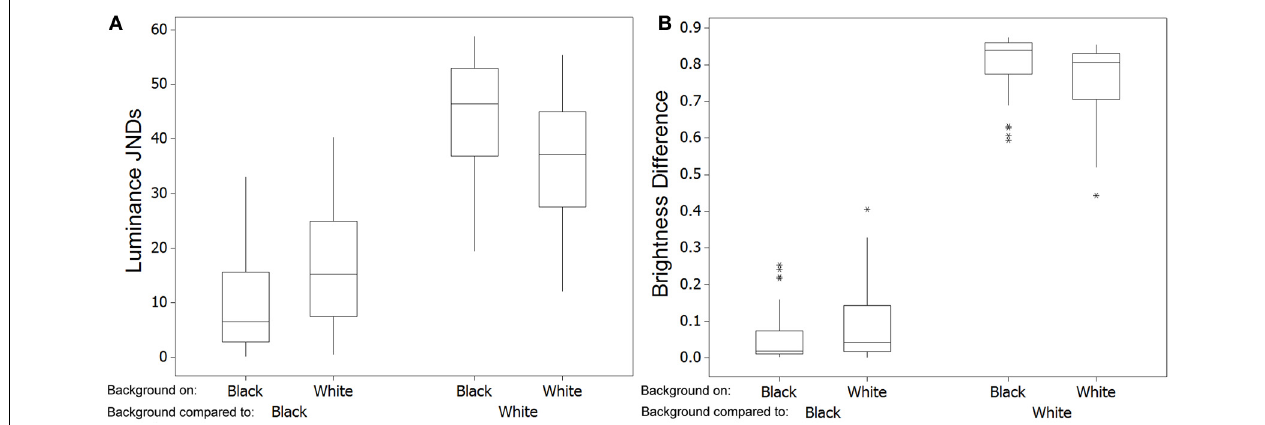
are crabs after being on a white background. Conversely, crabs were more similar in luminance to the white background when they had been on white rather than the black background. In general, being often quite dark, crabs are closer to the black than to the white background. (B) Shows the same comparisons and results except with data being absolute difference in brightness (total reflectance on a scale of 0–1)